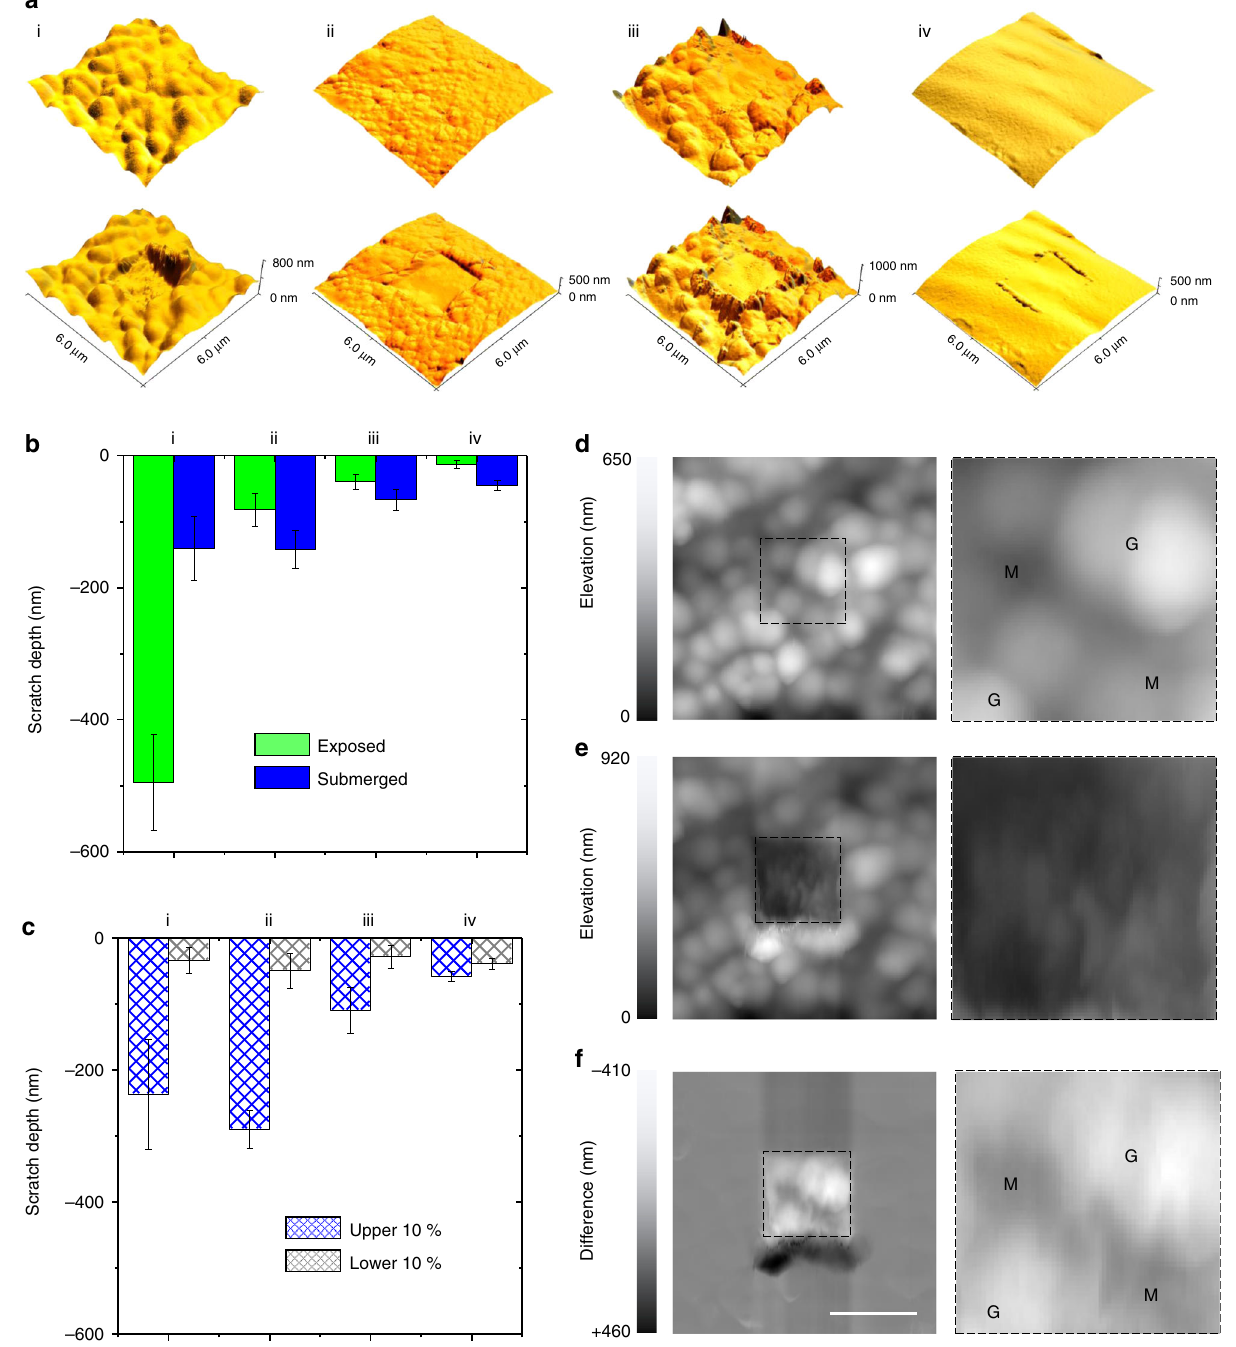
Fig. 2 2D AFM scratch tests on the cuticle surfaces. All panels labeled with (i) represent M. galloprovincialis , (ii) M. californianus , (iii) S. bifurcatus , and (iv) M. capax . a Representative AFM topographic images of all mussel thread surfaces without (top) and with (bottom) scratch traces. b Scratch depths as a function of species and hydration. c The hydrated datasets are further partitioned in the upper and lower 10%. d – f A representative scratch test on a M. galloprovincialis thread (scale bar = 2 µ m), with AFM height channel recordings prior ( d ) and after ( e ) damaging the surface, as well as a difference image of both ( f ). Zoom-ins of the region of interest are included on the right (M = matrix and G = granules) (Bars are mean ± s.e.m., n = four biological